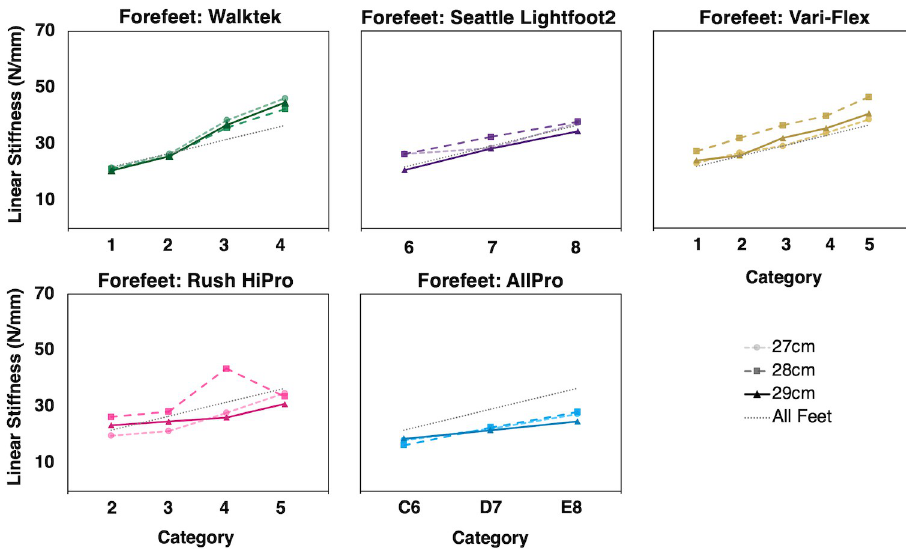
Fig 3. Calculated linear stiffness of prosthetic forefeet by scaled stiffness category (min 1, max 5). Five types of commercial prosthetic feet with three different foot sizes (i.e., 27-29cm) tested for each stiffness category (for a total of 15 groups, where group is defined by all feet of the same type and size). Dashed lines indicate the regression slope averaged across all foot types and sizes from linear mixed effects regression of calculated stiffness on stiffness category and size, with random effects for foot type and foot type by stiffness category interaction. Calculated linear stiffness was significantly associated with scaled stiffness category ( p = 0.001), although depending on foot type, variability in stiffness across foot sizes and across consecutive stiffness categories is observed ( p <